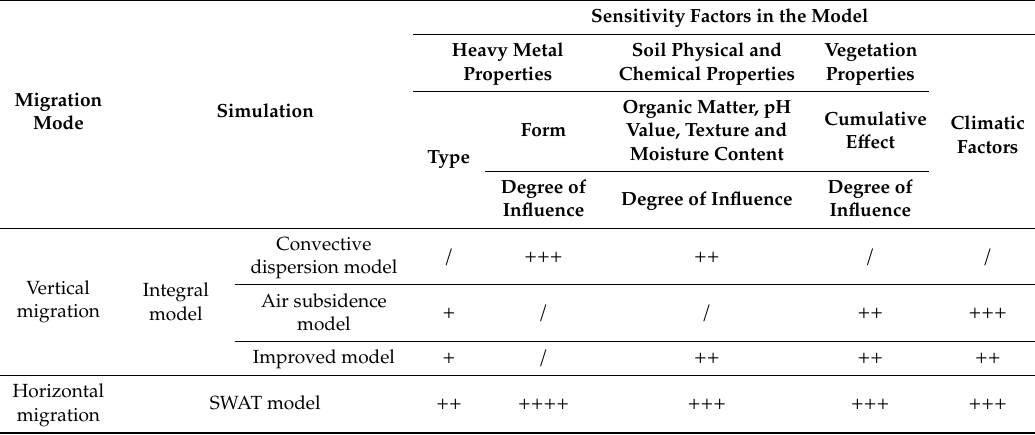
Table 2. Sensitivity parameters of the di ff erent models.